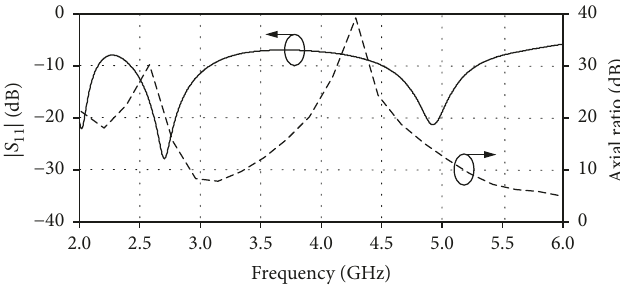
Figure 4: Simulated results of the truncated square patch antenna with slant strip.